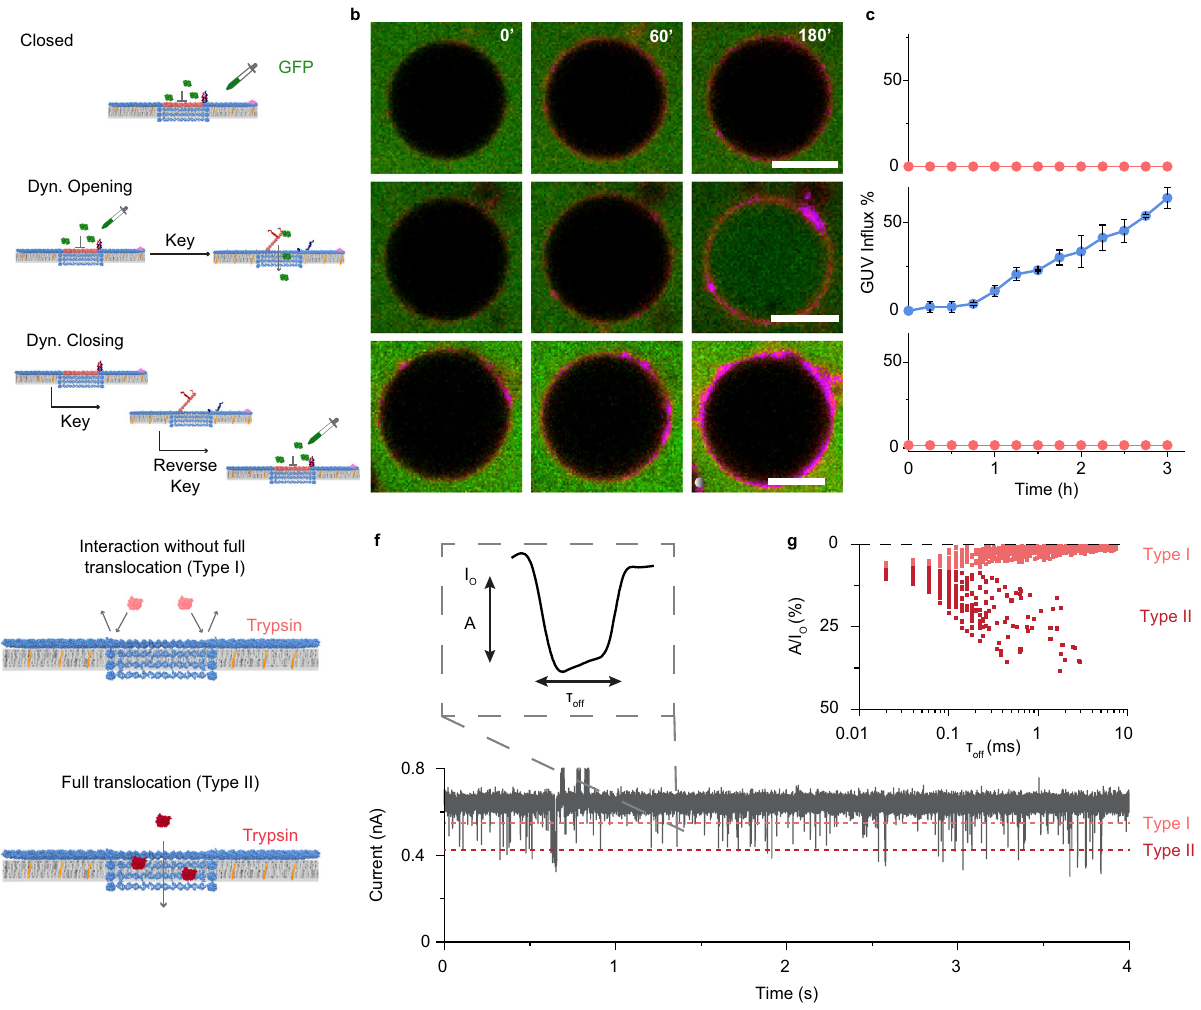
Fig. 5 Reversibly gated protein transport by large diameter nanopore. a Scheme of GFP-in fl ux assay using GUVs. b Respective time series of confocal images at the given time points showing Cy5-labeled LGC (magenta) and GFP (green). Scale bars: 10 μ m. c Percentage of GUVs showing in fl ux over time for Closed, Dyn. Open, and Dyn. Closed versions of LGC. The plots show the average percentage of in fl ux and standard deviation from n = 125, 255, and 125 GUVs, respectively, from three independent experiments. See Methods section on how data were analyzed to identify in fl ux. d , e Scheme depicting the electrophysiological characterization of trypsin transport through an LGC showing Type I ( d ) and Type II ( e ) events. f Representative single-channel current trace of LGC-N at + 80mV after the addition of 6.6 μ M trypsin to the cis chamber obtained at 50kHz sampling rate. Inset shows an isolated translocation event characterized by dwell time ( τ off ) and blocking amplitude ( A / I O ). g A scatter plot of individual trypsin translocation events based on τ off and A / I O